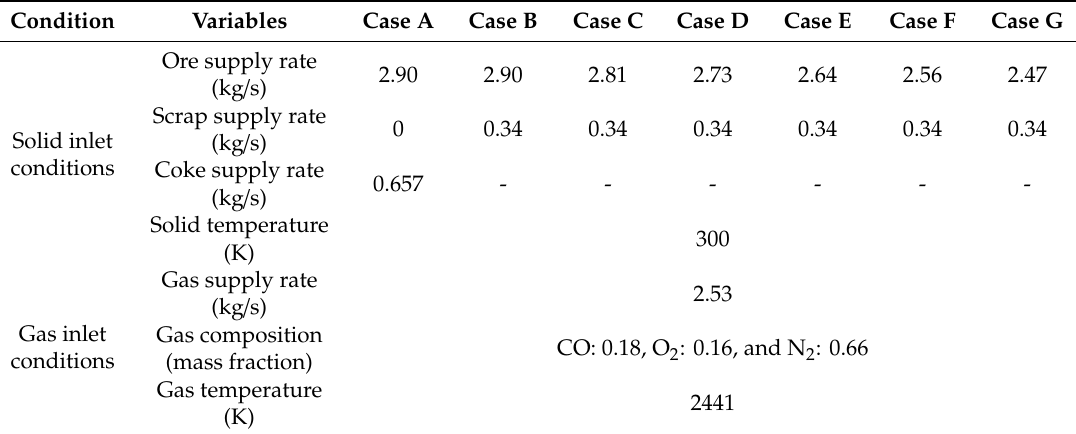
Table 7. Gas and solid inlet conditions of di ff erent cases (1 / 20 BF